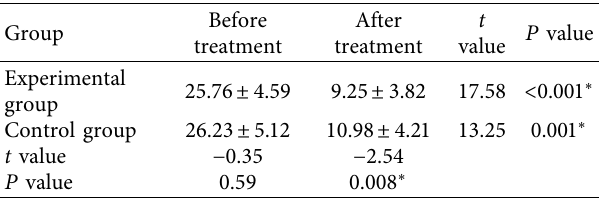
Table 1: Comparison of the scores of the HAMD-17 scale between the experimental group and control group before and 8 weeks after treatment.